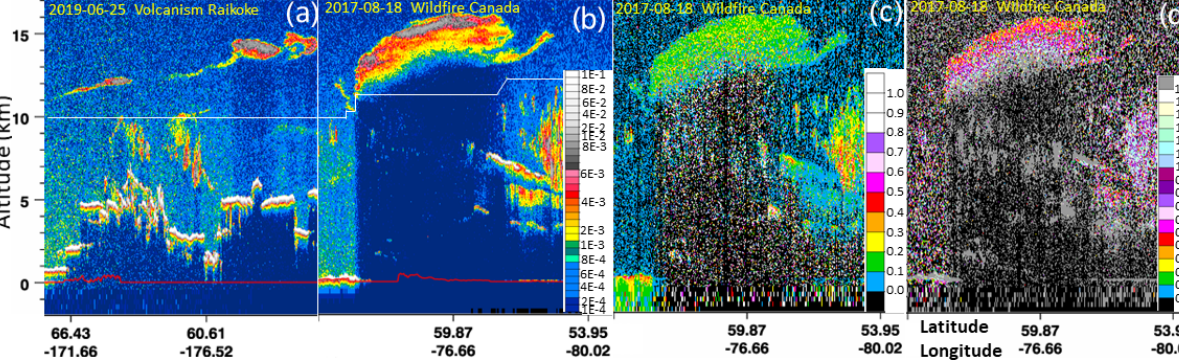
Figure 1. CALIOP curtains of total attenuated backscatter (km − 1 sr − 1 ) at 532nm from (a) volcanic aerosol layers in the stratosphere 3d after the 2019 Raikoke eruption and (b) a stratospheric smoke layer from the 12 August 2017, North American wildfire, where “ a E- b ” in the scale refers to a × 10 − b . (c) Volume depolarization ratio at 532nm and (d) attenuated color ratio (1064 to 532nm) for the curtain in (b) . The white lines in (a) and (b) show the position of the